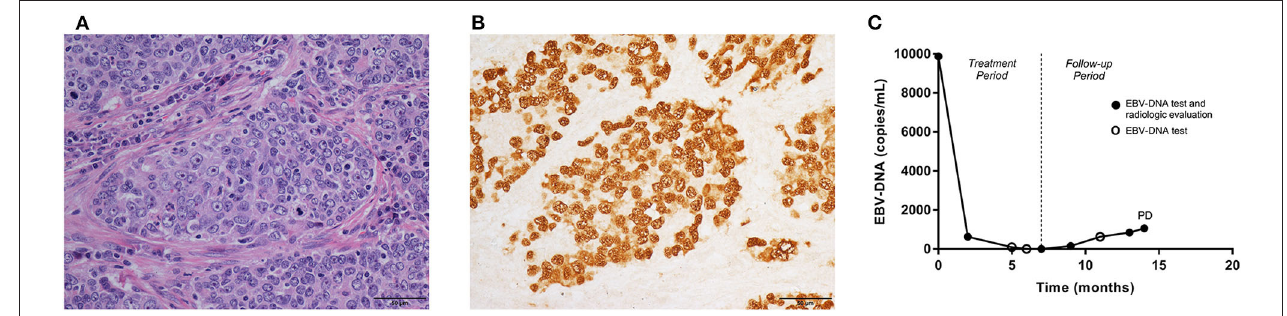
FIGURE 1 | Pathologic features, the fluctuations of EBV-DNA copy number and disease development in one pulmonary LELC case. A 60-year-old, male patient was diagnosed with stage IIIA pulmonary LELC. He received radical surgery, adjuvant chemotherapy, and post-operative radiotherapy. Using the surgical specimen, (A) the Hematoxylin-eosin (HE) staining ( × 400) showed epithelial tumor cells nests surrounded and infiltrated by lymphocytes. (B) EBERs ( × 400) were detected by in situ hybridization in tumor cells. (C) The patient had pre-treatment EBV-DNA concentration of 9,870 copies/mL, and it decreased to zero after multimodality therapy. The EBV-DNA copy number had a slow increase during follow-up, but no trace of recurrence was found within the first 13 months since start of treatment. Once EBV-DNA copy number exceeded 1,000 copies/mL (1,060 copies/mL) at 14th months, a solitary metastasis in the liver was observed simultaneously by computed tomography. EBV, Epstein-Barr virus; DNA, deoxyribonucleic acid; LELC, lymphoepithelioma-like carcinoma; EBERS, EBV-encoded small non-polyadenylated RNAs; PD, progressive